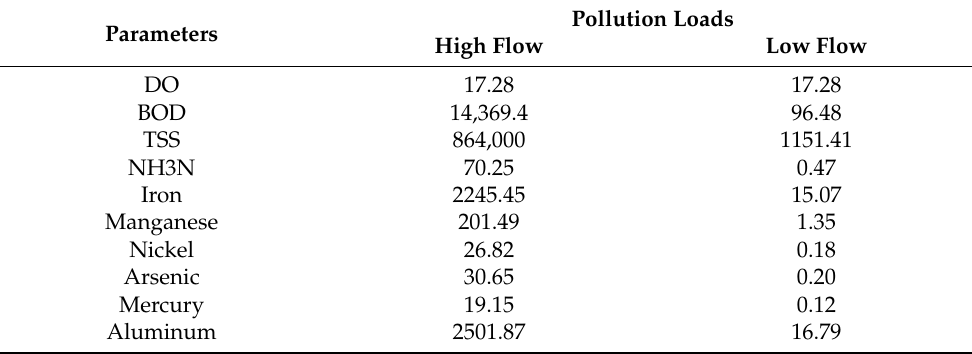
Table 5. Pollution load in